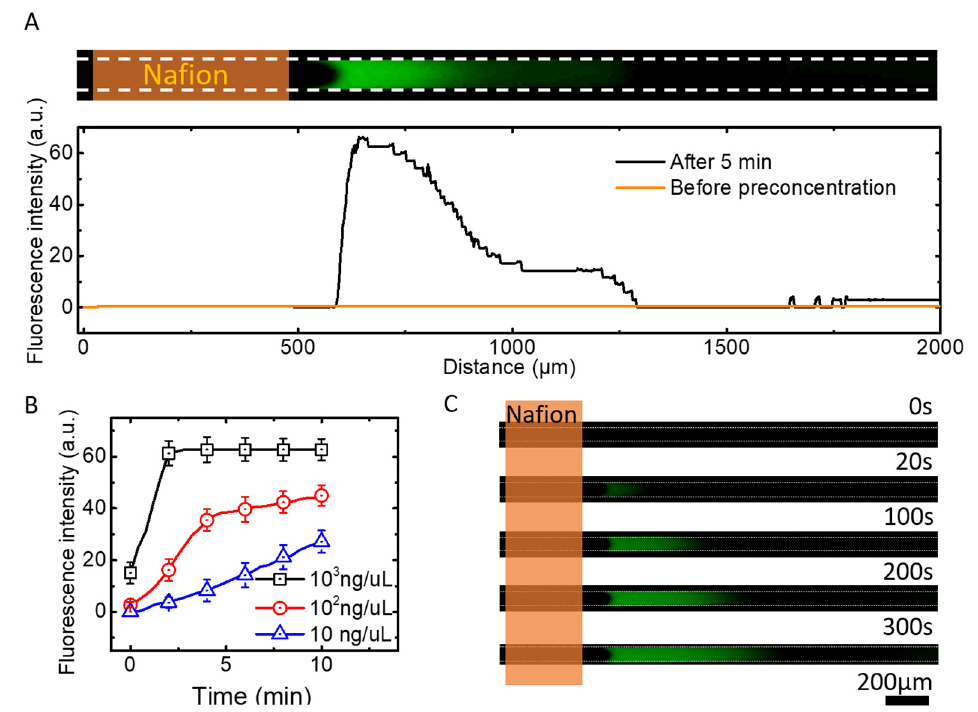
Figure 3. ( A ) Phenomenon of ion concentration polarization with electric field 25 V/cm. ( B ) Fluorescence intensity of different concentrations (10 ng/ μ L,10 2 ng/ μ L and 10 3 ng/ μ L) of sodium fluorescein aqueous solution with the preconcentration operation. ( C ) Experimental image of fluorescence intensity changing with time at the concentration of 10 3 ng/ μ L.